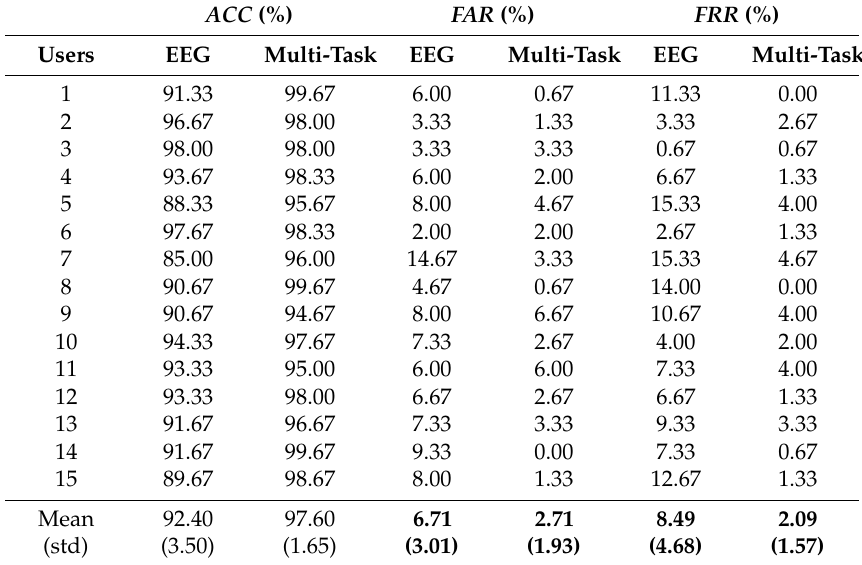
Table 2. Performance of EEG-based and multi-task person authentication system in